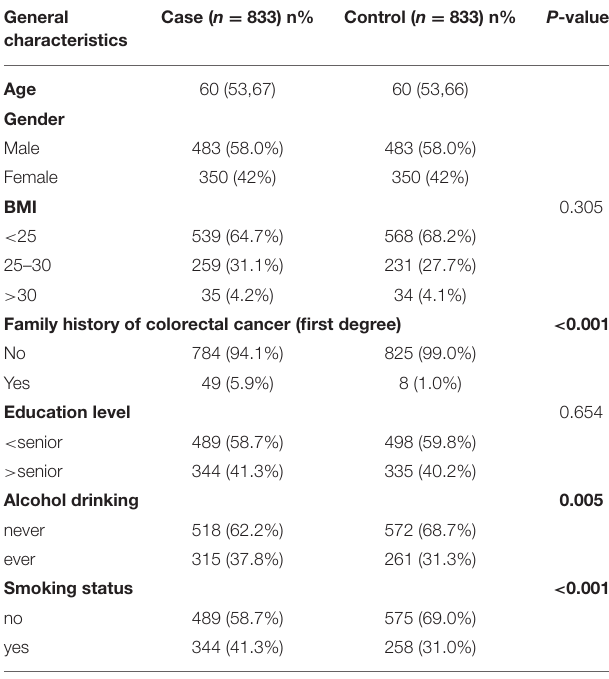
TABLE 1 | General characteristics of all